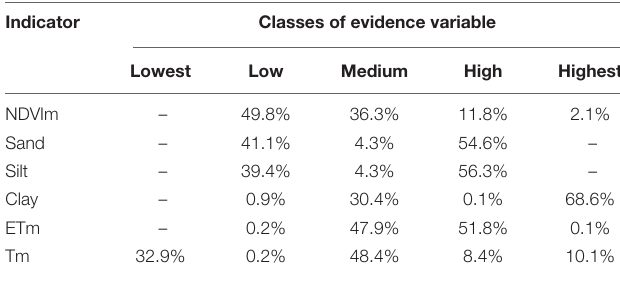
TABLE 2 | Comparison of evidence variables in different states in high-risk areas.